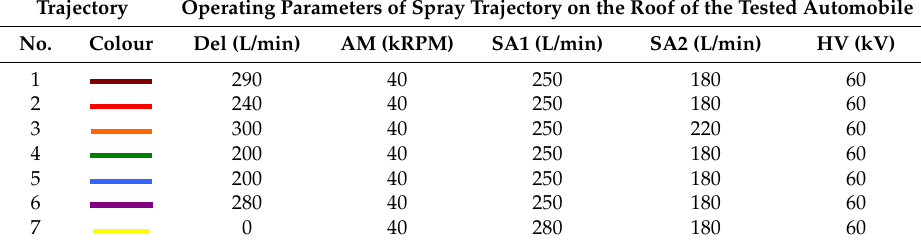
Table 1. Operating parameters of spray trajectory on the roof. Table 2. Operating parameters of spray trajectory on the side.